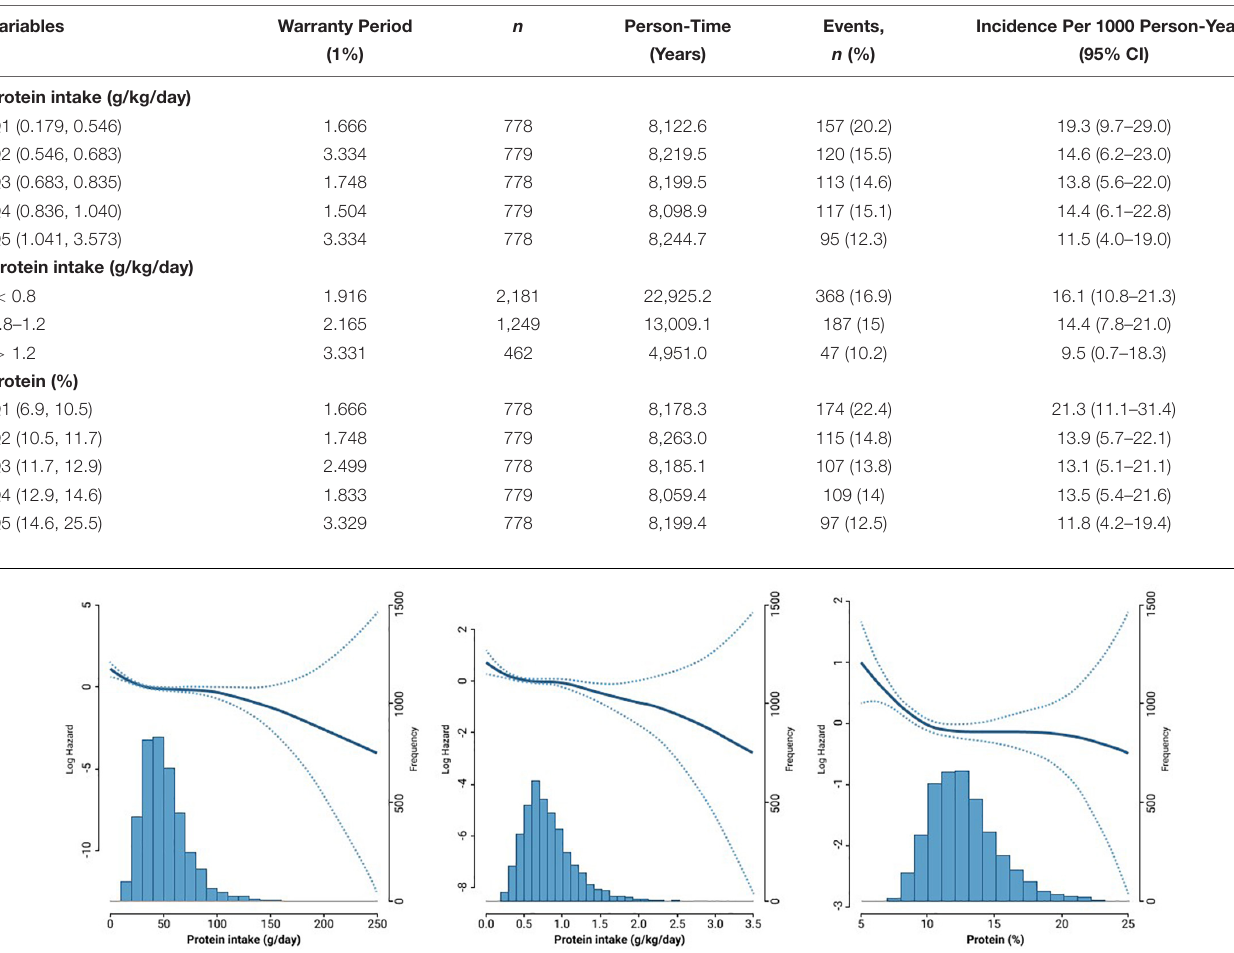
TABLE 2 | Warranty periods for all-cause mortality according to protein intake (g/kg/day). Variables Warranty Period n Person-Time Events, Incidence Per 1000